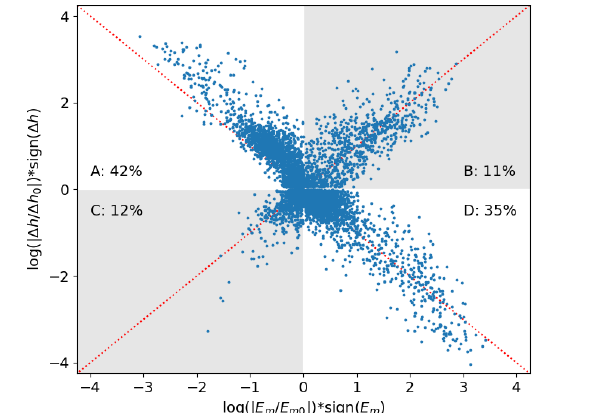
Figure 4. Relation between signed and normalized ∆ h values and released mechanical energy, for matched events. A-D: four di ff erent behaviors with percentage of events in each classifica- tion.